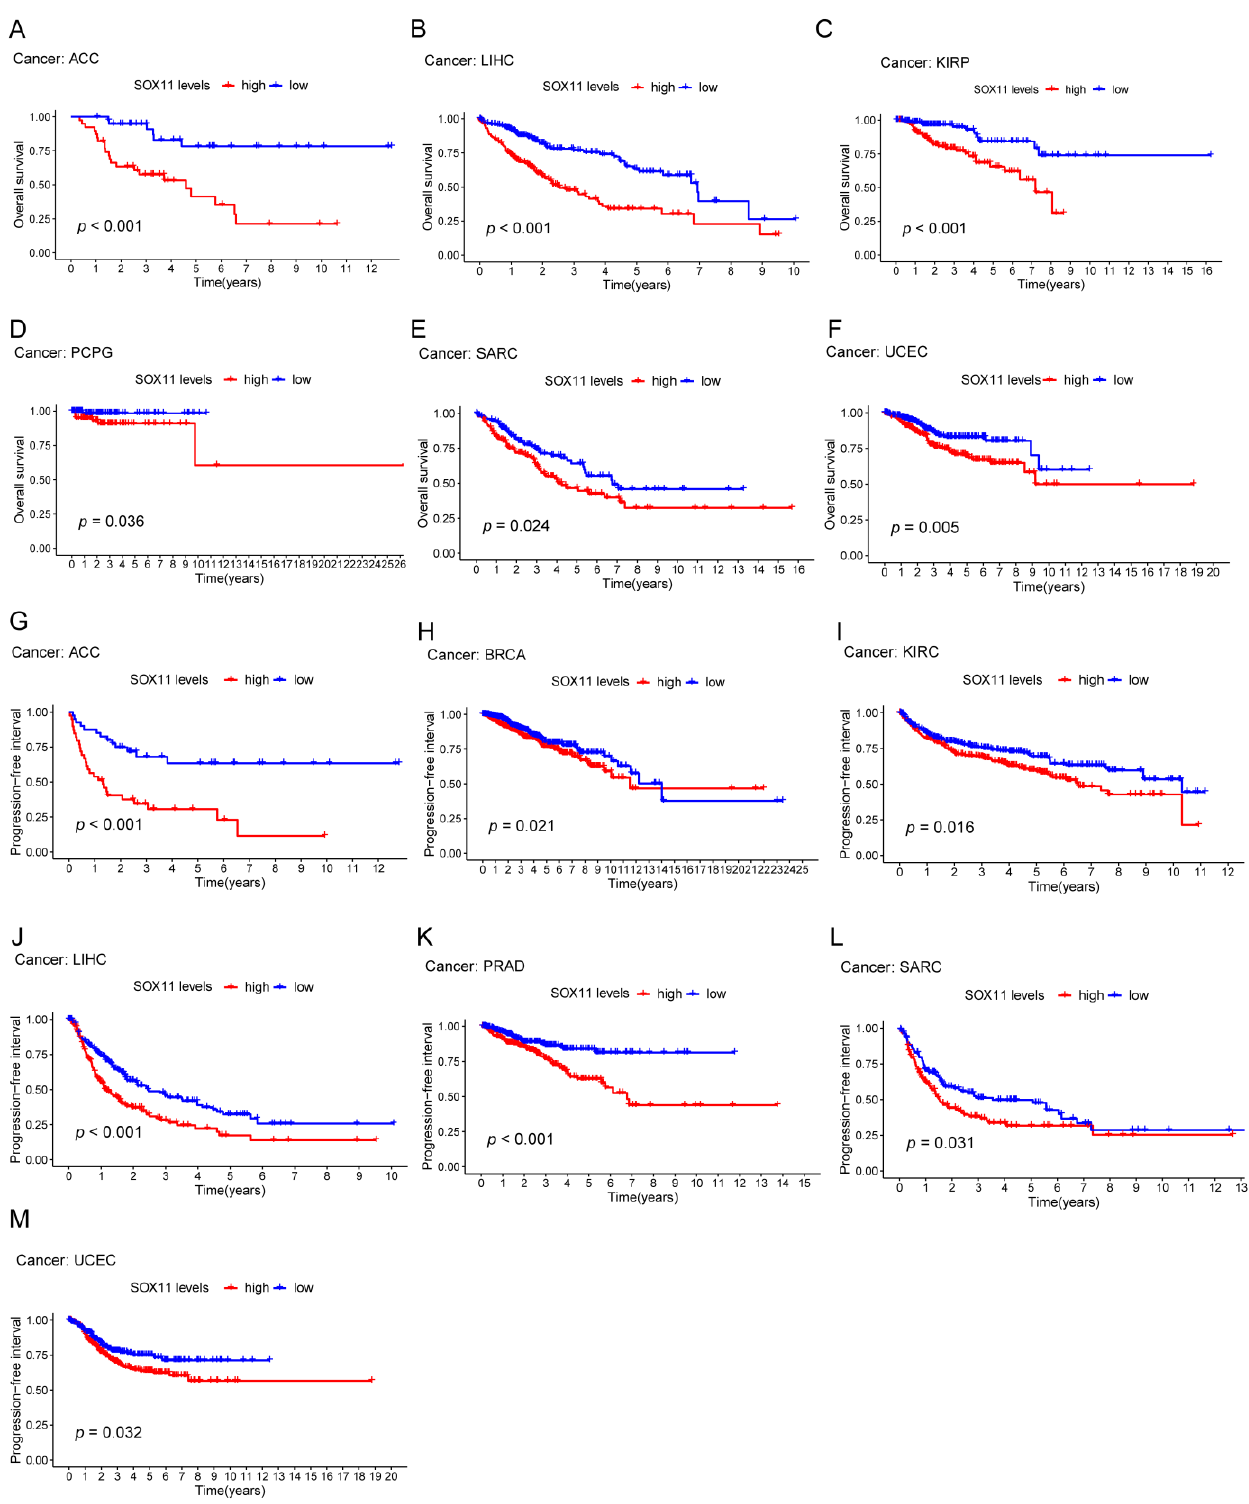
Figure 2. Protein expression level of SOX11 in human multiple cancer tissues and normal tissues of THCA ( A ), ESCA ( B ), STAD ( C ), COAD ( D ), READ ( E ), LIHC ( F ), PAAD ( G ), LUSC ( H ), LUAD ( I ), BRCA ( J ) and KIRC ( K ). Representative images of SOX11 expression in pan-cancer tissues are shown. Original magnification, ×40 and ×100, Scale bar: black, 200 μm; red, 100 μm.